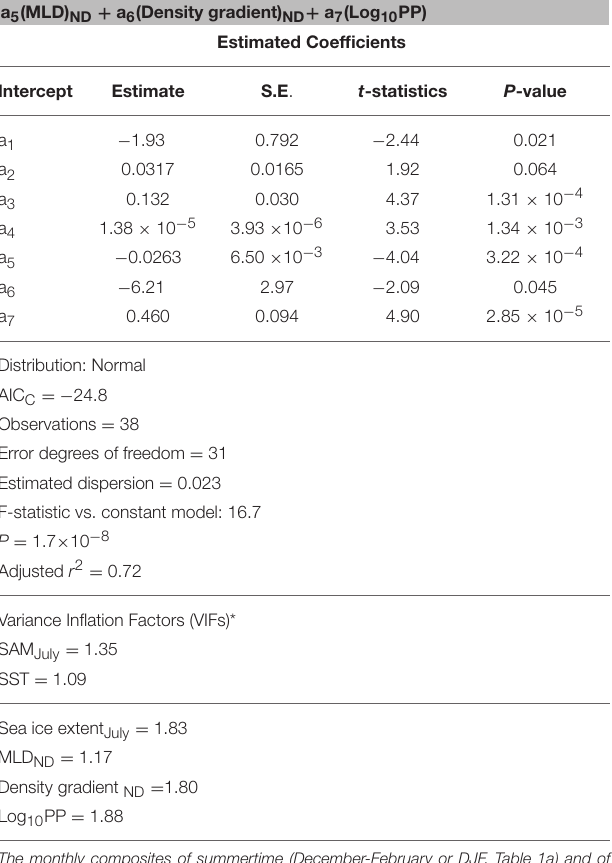
Figure 5A ). The 11-year mean BP:PP ratio was 0.04, showing considerable interannual variability in the ratio. Annual-scale PP-BP regressions were largely absent except for 2005–2006 and 2010–2011 with slope values of 0.57 and 0.46, respectively ( Figure 4A ). In contrast, significant Chl-BP regressions were more frequent with slope values ranging from 0.33 to 0.56 (years 2005–2006, 2009–2010, 2010–2011, 2013–2014, and 2014–2015; Figure 4A ) showing a considerable interannual variability in the degree of Chl control on